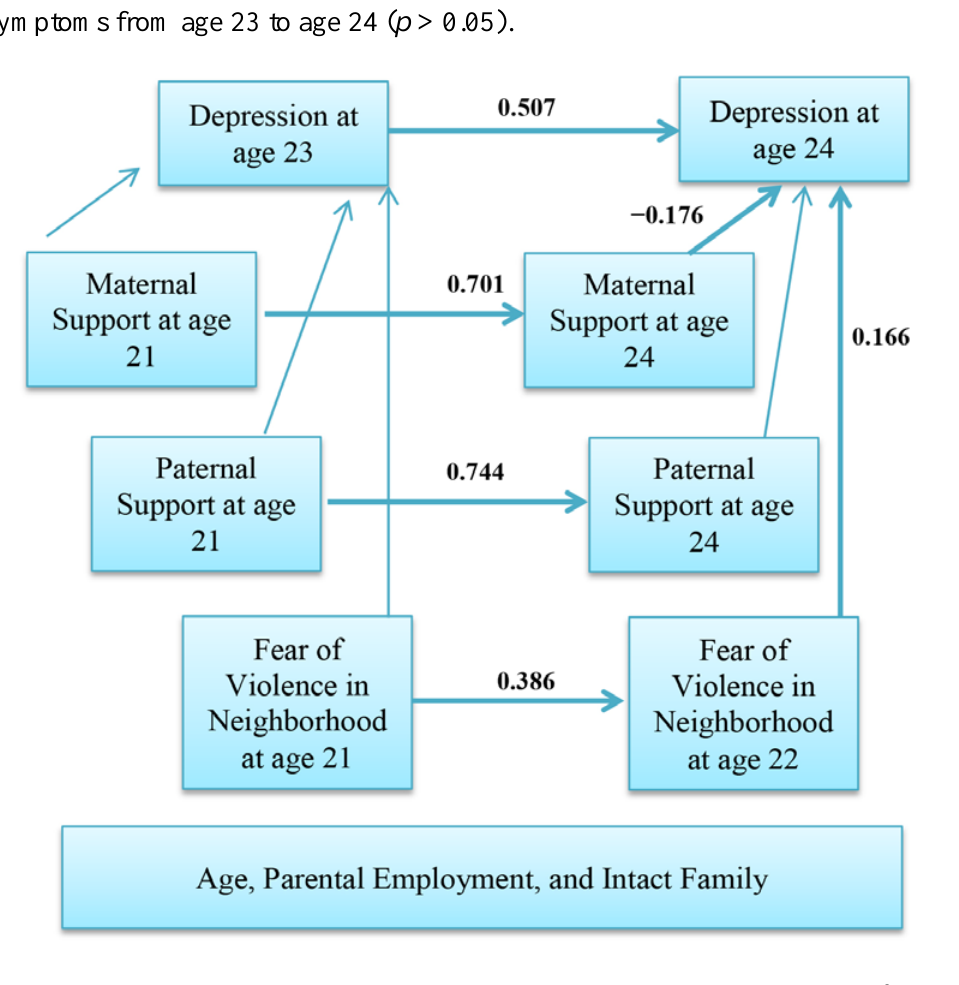
Figure 1. Summary of path analysis among male African American youth. [χ 2 = 82.126, df = 52, p = 0.005, χ 2 /df = 1.579, root mean squared error of approximation (RMSEA) = 0.029, (90% CI = 0.016, 0.041)]. Paths from covariates and also covariance